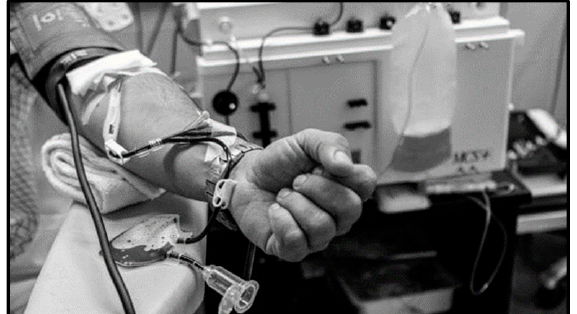
Figure A7. Monoclonal antibodies.